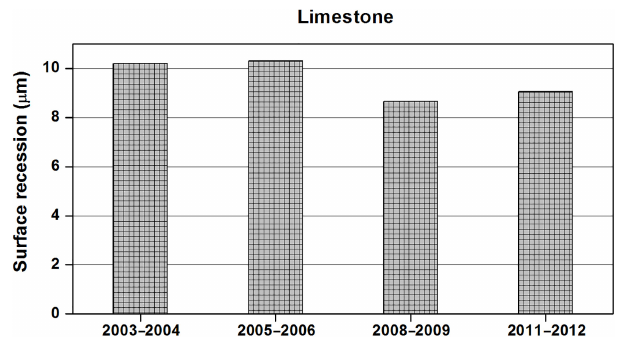
Figure 5. Surface recession of limestone exposed in